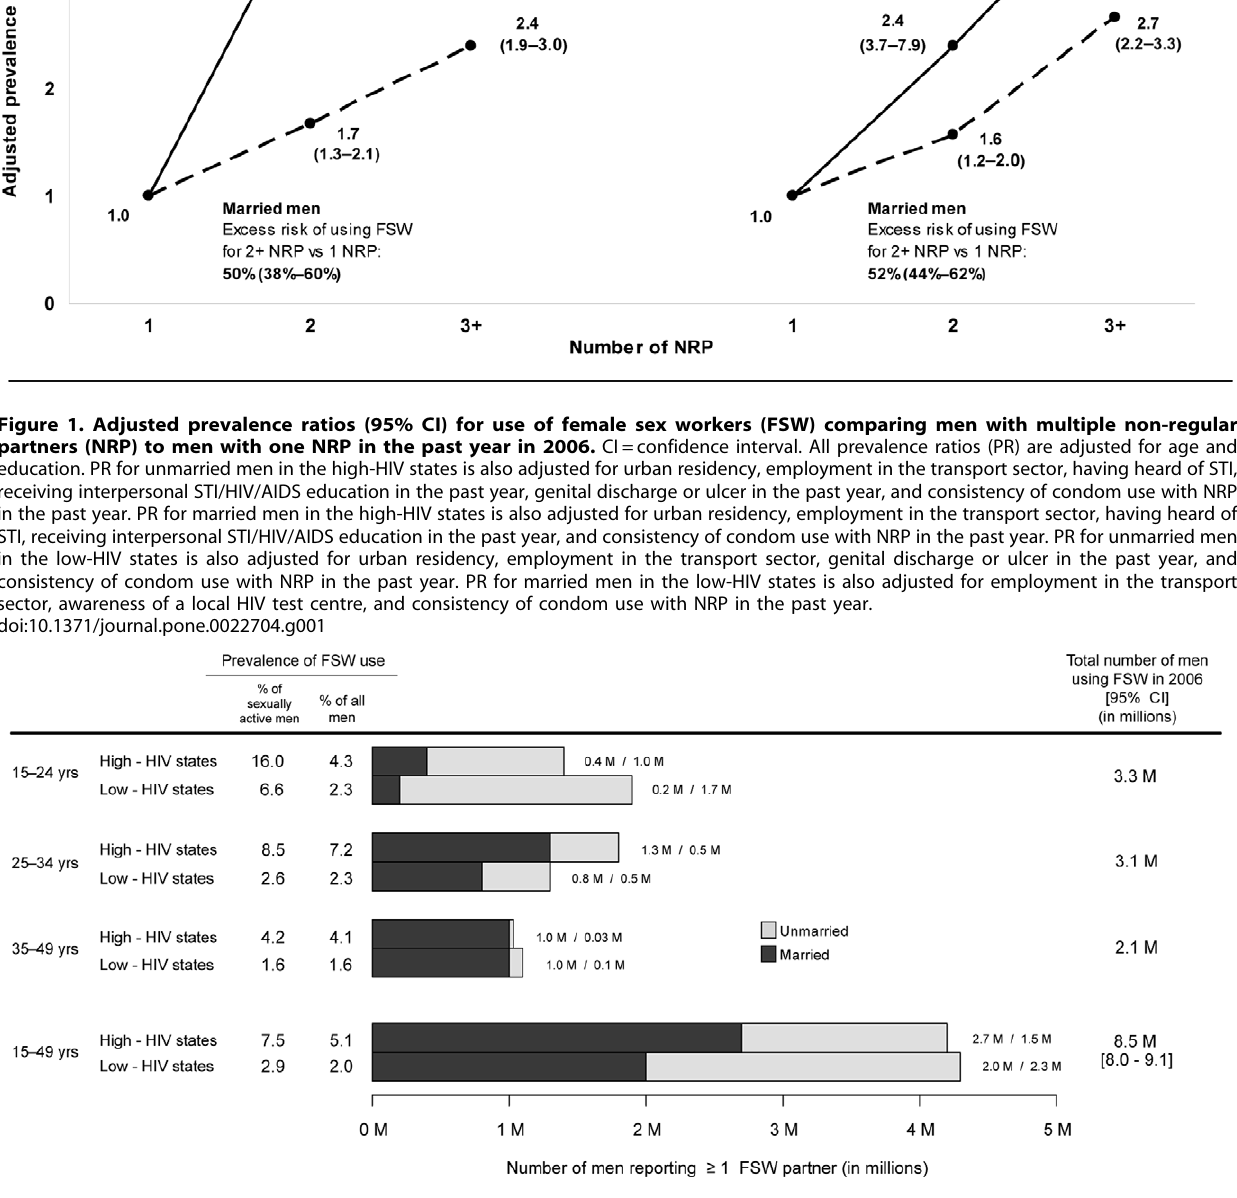
Figure 2. Estimated number of unmarried and married men in India reporting at least one female sex worker (FSW) partner in the past year in 2006. CI=confidence interval. Men from the seven northeastern states (i.e. Arunachal Pradesh, Manipur, Meghalaya, Mizoram, Nagaland, Sikkim and Tripura; about 4% of the national adult male population) are excluded.